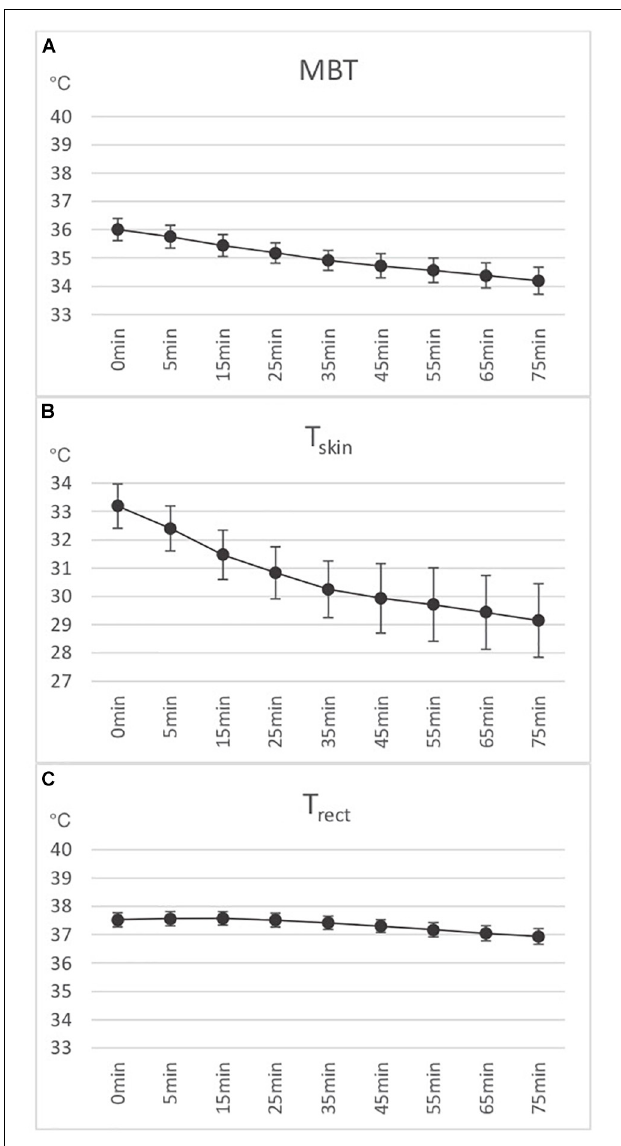
FIGURE 2 | (A) Calculated mean body temperature (MBT) ( n = 7). (B) Area weighted skin temperature (T skin ) ( n = 7). (C) Rectally measured deep body temperature (T rect ) ( n = 7). Means and standard errors